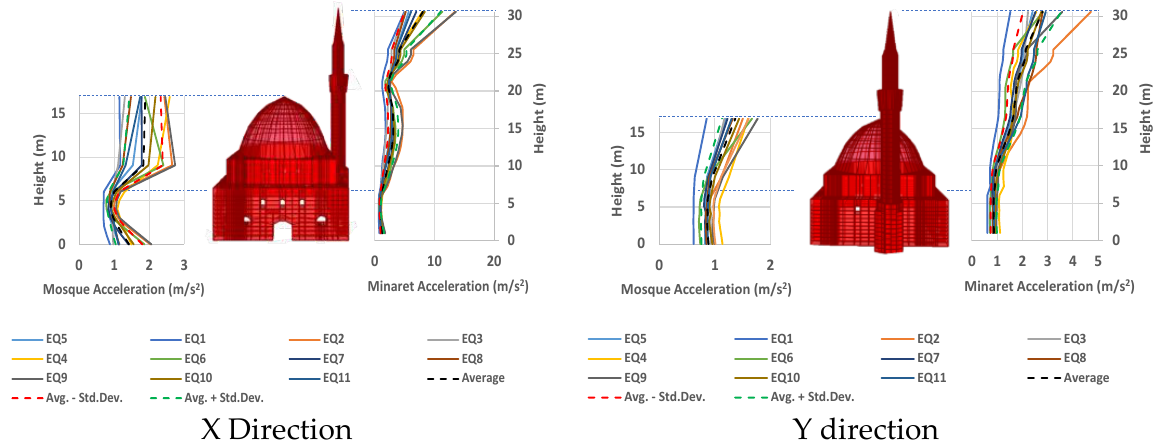
Figure 11. Mosque and minaret absolute acceleration for the base-isolation case. Figures 10 and 11 show the maximum absolute accelerations at the determined levels, which were evaluated by time history analyses. It can be observed that the increase in stiffness compared to the LRB isolator caused an increase in acceleration values, even though it caused a decrease in displacements. Figures 10 and 11 show that average mosque level acceleration during earthquakes in the base-isolated building model decreased by 83% and by 92% for the X-direction and Y-direction, respectively, and average minaret level acceleration during earthquakes in the base-isolated building model decreased by 63% and by 82% for the X-direction and Y-direction,